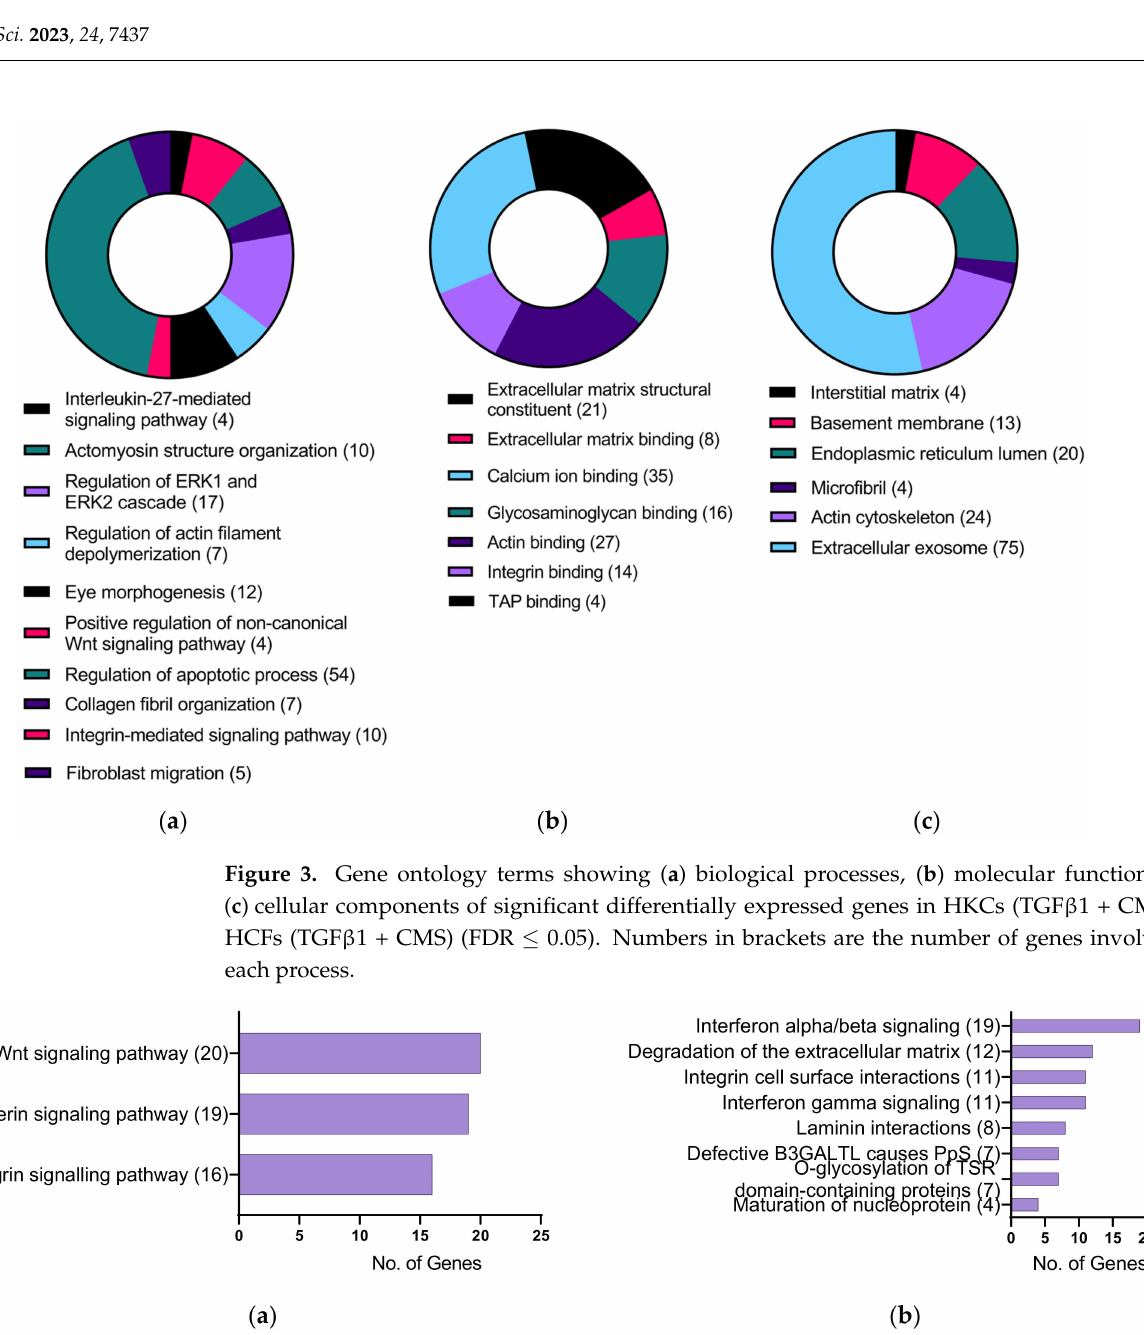
Figure 4. ( a ) PANTHER and ( b ) Reactome pathway analyses for significantly differentially expressed genes in HKCs (TGF β 1 + CMS) vs. HCFs (TGF β 1 + CMS) (FDR ≤ 0.05). Numbers in brackets are the number of genes involved in each